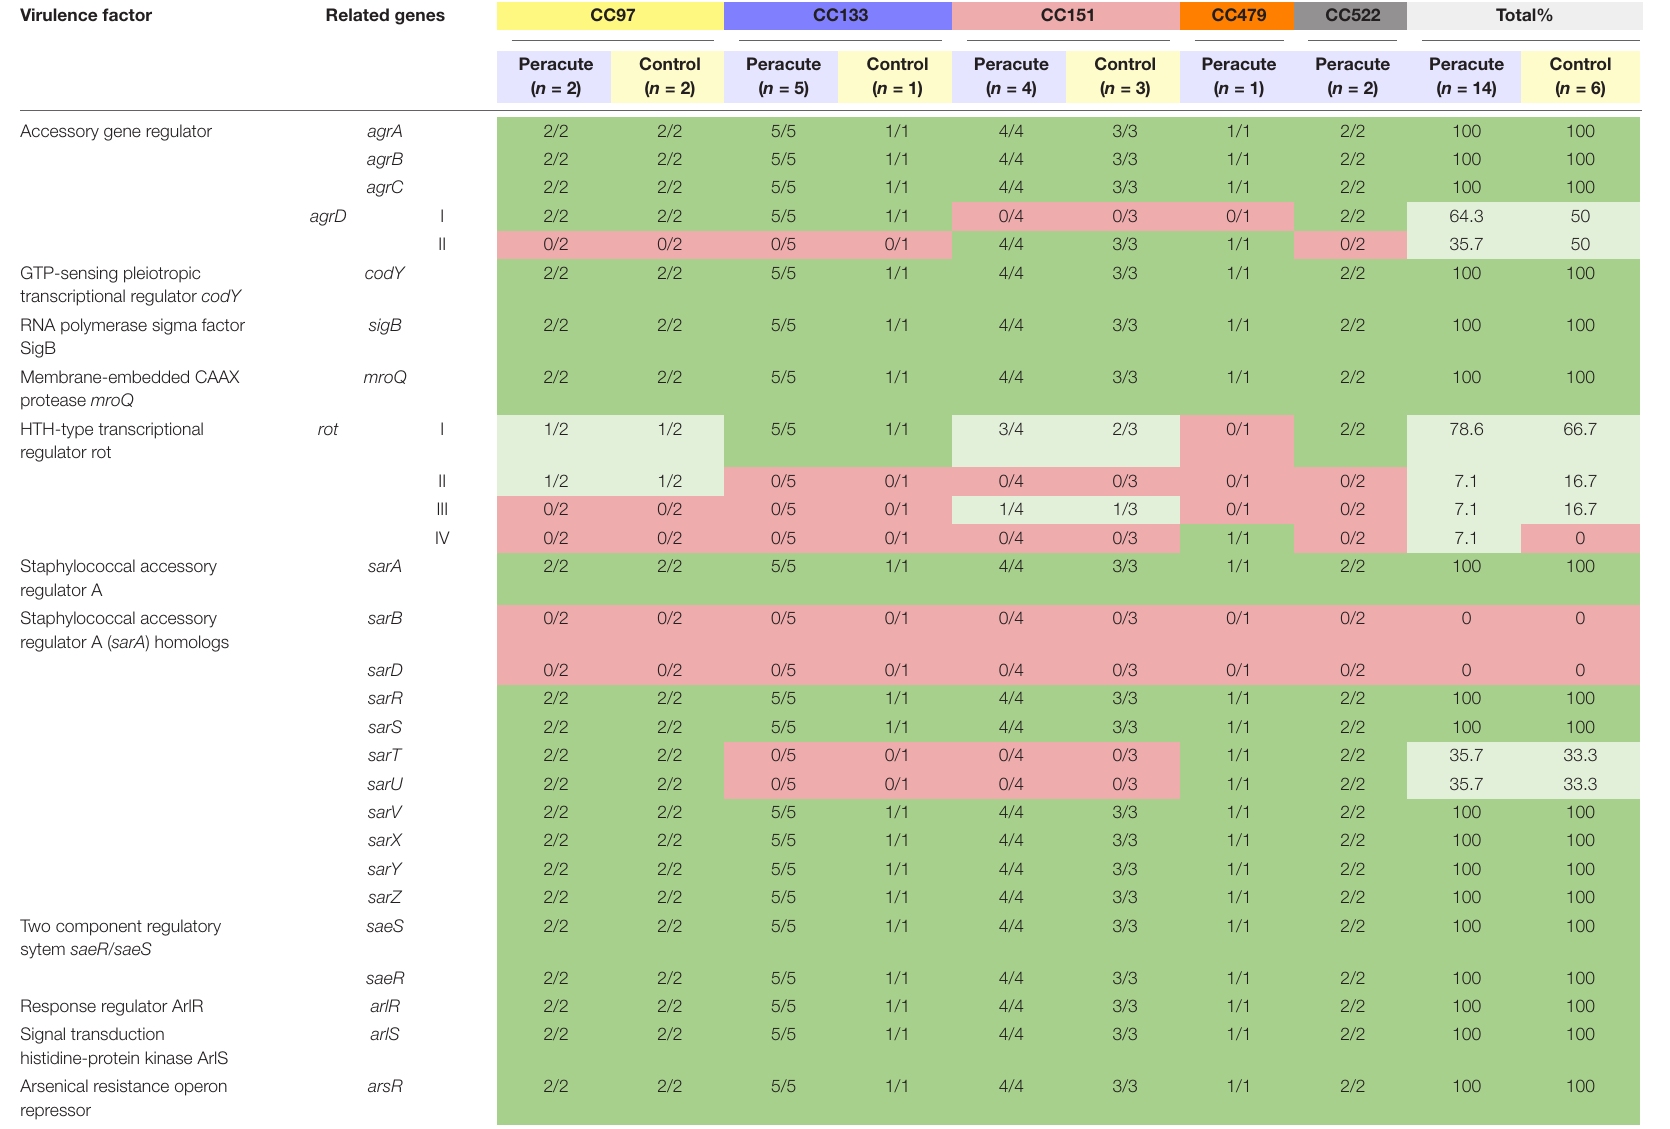
TABLE 9 | Distribution of regulatory genes in 20 Staphylococcus aureus isolates from bovine mastitis milk samples classified by clonal complex (CC) and study